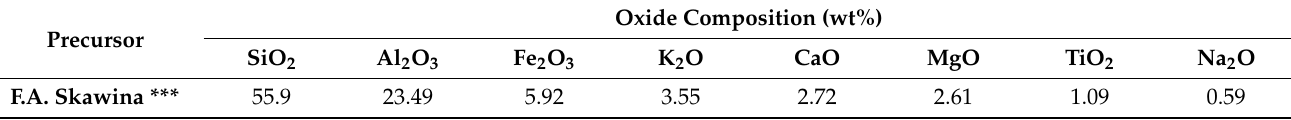
Table 2. Oxide composition of the Skawina charcoal fly ash.